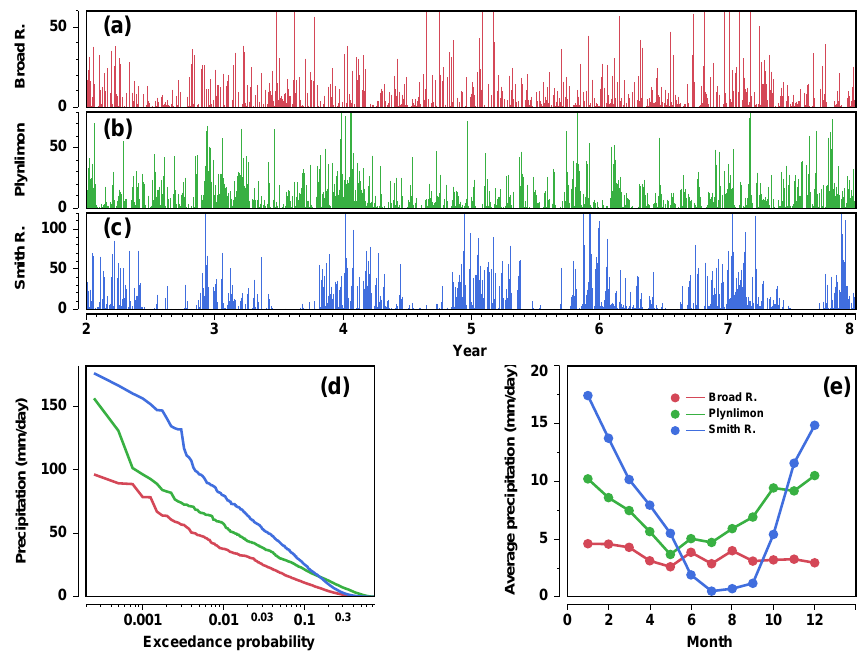
Figure 2. Excerpts of daily precipitation records used to drive the model: (a) Broad River, Georgia, USA (humid temperate climate; Köppen climate zone Cfa) in red, (b) Plynlimon, Wales (humid maritime climate; Köppen climate zone Cfb) in green, and (c) Smith River, Califor- nia, USA (Mediterranean climate; Köppen climate zone Csb) in blue. Axes are expanded to make typical storms visible; thus, the largest storms, some of which extend to roughly twice the axis limits, are cut off. Exceedance probability (d) shows a steeper magnitude–frequency relationship for Smith River than for the other two records. Monthly precipitation averages (e) show clear differences in seasonality among the three